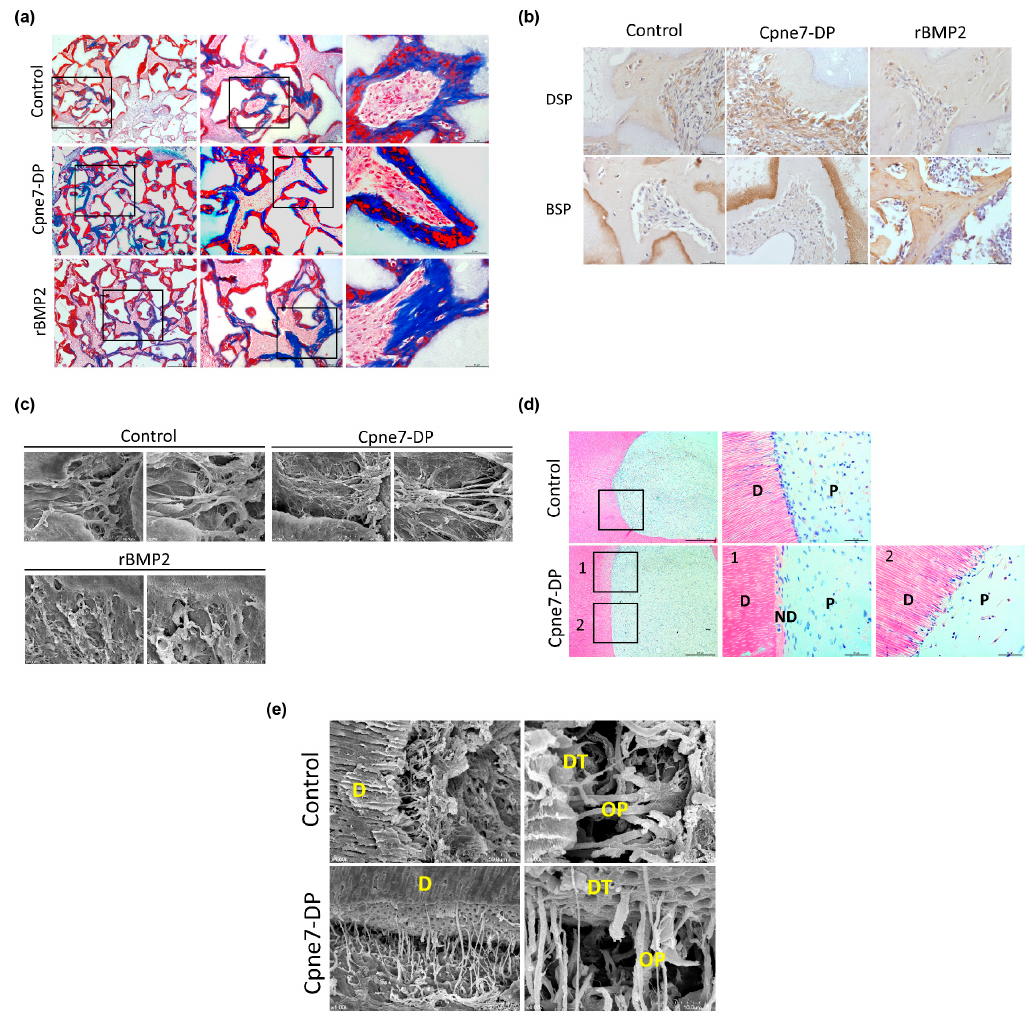
Figure A3. Functional peptide, Cpne7-DP, induces dentin-like tissue formation in vivo. ( a ) Masson’s trichrome staining of the subcutaneously transplanted 100 mg HA/TCP particles alone or with Cpne7-DP or rBMP2 in a 0.5% fibrin gel into immunocompromised mice for 12 weeks. ( b ) Regenerated tissues were immunostained with anti-DSP or anti-BSP. ( c ) Scanning electron microscopic analysis of cell morphology at the cell/hard tissue interfaces. ( d ) Histological analysis of the subcutaneously transplanted emptied root canal spaces of the human tooth segments filled with hDPCs alone or together with Cpne7-DP in a 0.5% fibrin gel into immunocompromised mice for 6 weeks. Samples were stained with hematoxylin-eosin. ( e ) Scanning electron microscopic analysis of the dentin/pulp interfaces. P, pulp; D, dentin; ND, new dentin; DT, dentinal tubules; OP, odontoblast process.